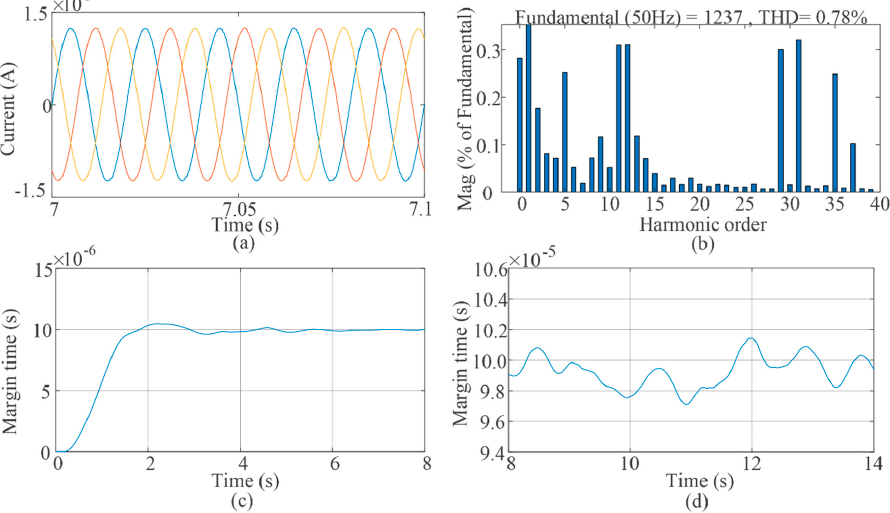
Figure 20. Line currents ( a ), the (THD) analysis of phase A current ( b ), dynamic process ( c ), and steady state of the margin time ( d ) with the proposed closed-loop dead-time compensation applied.